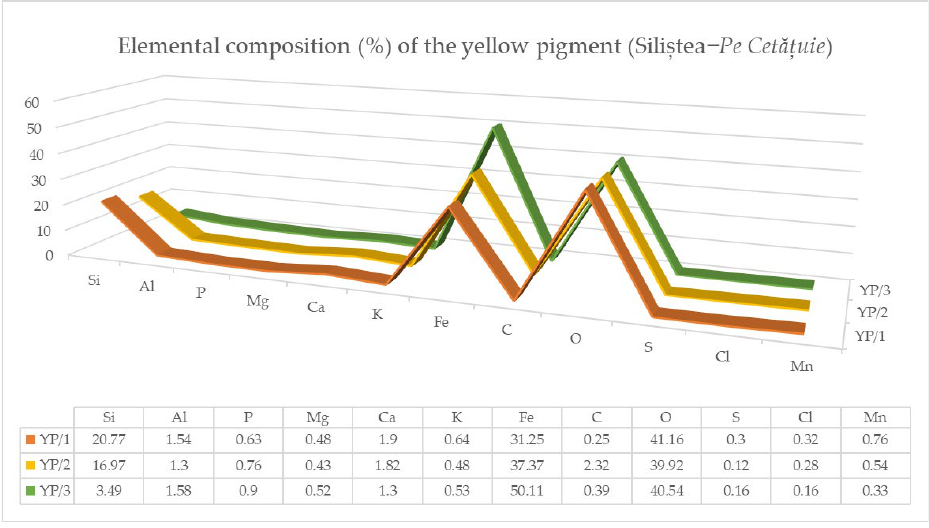
Figure 14. The elemental composition of the yellow pigment from the Siliștea — Pe Cetățuie settlement.